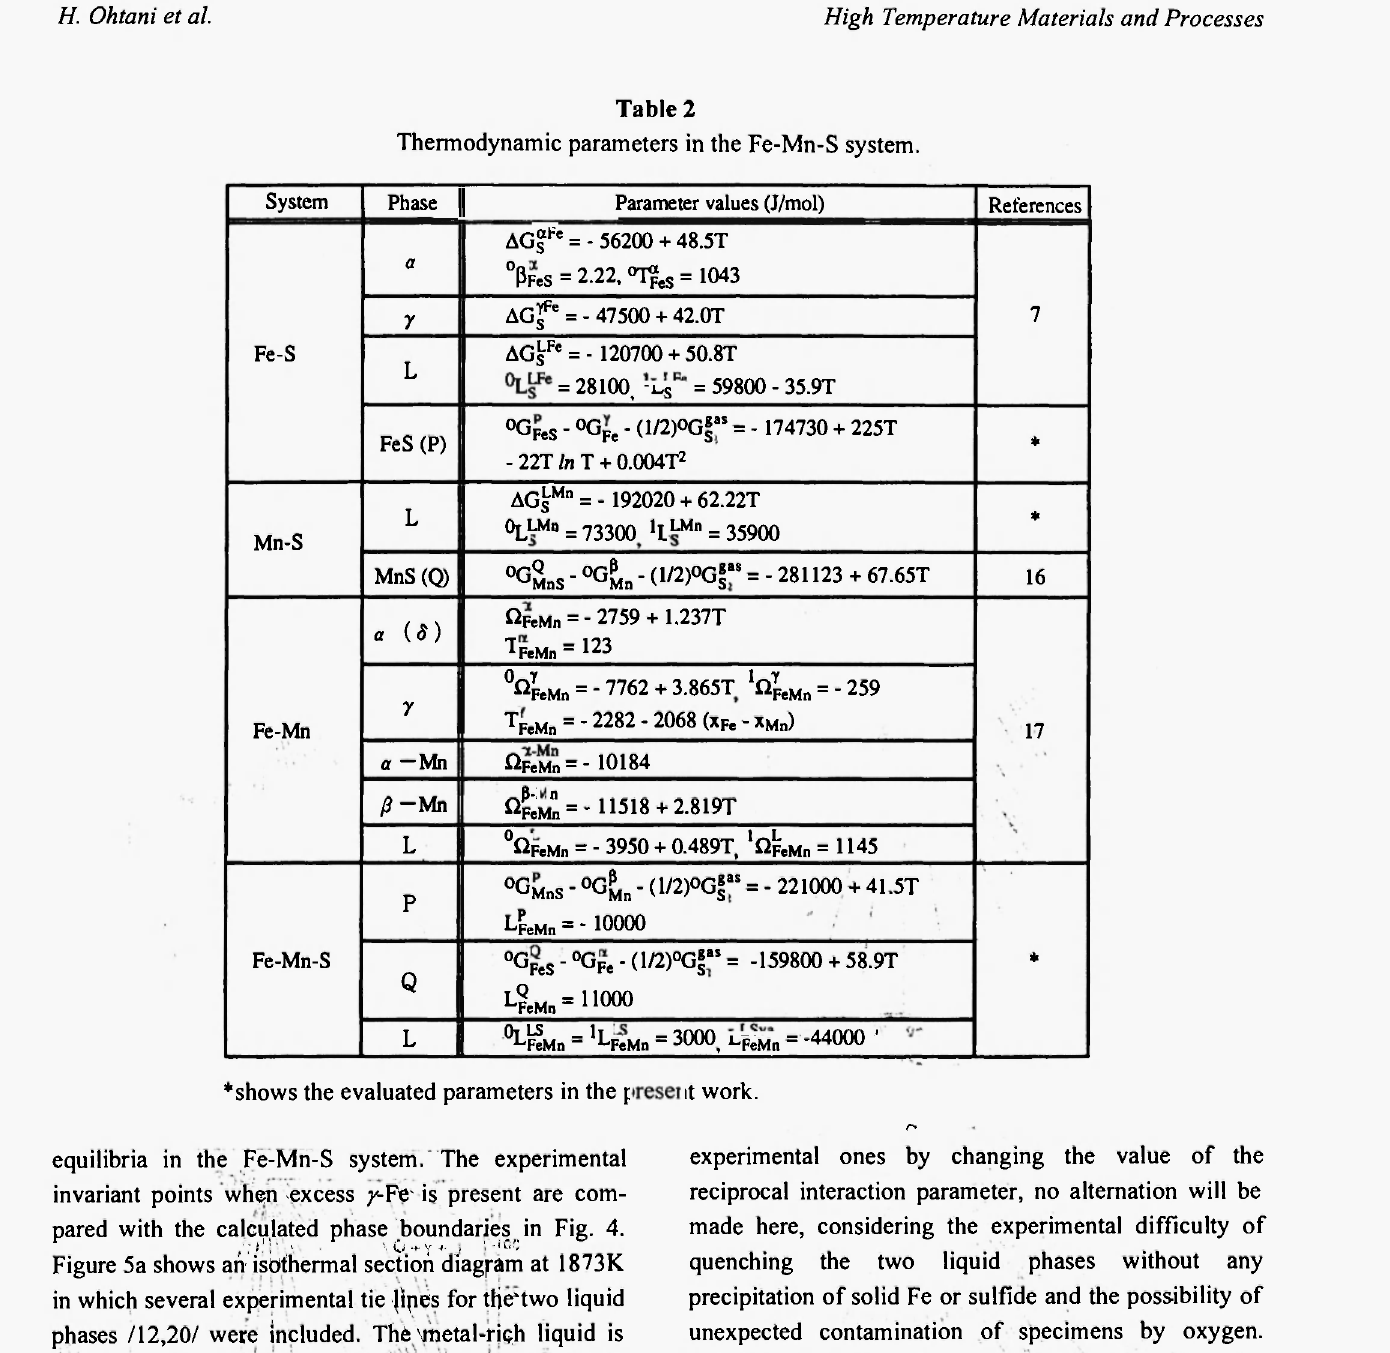
experimental phase boundary data /21